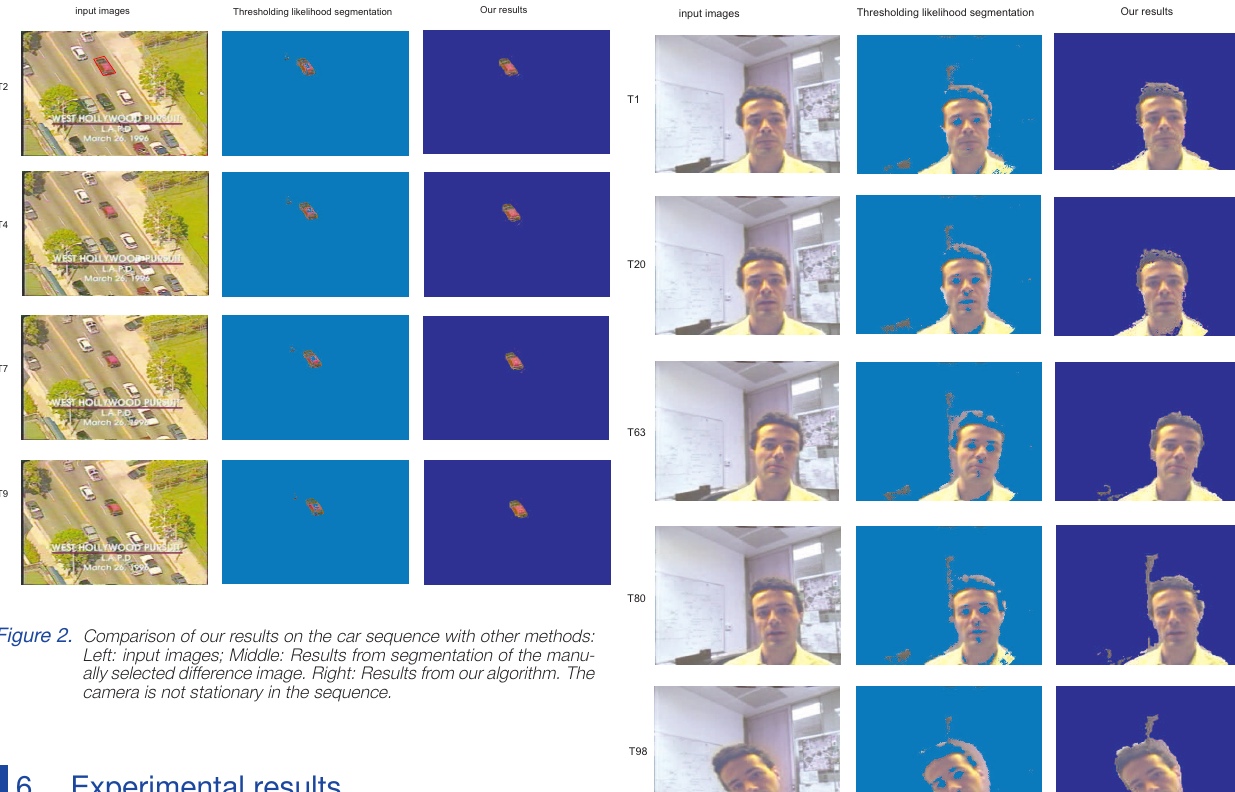
learned priors to specific